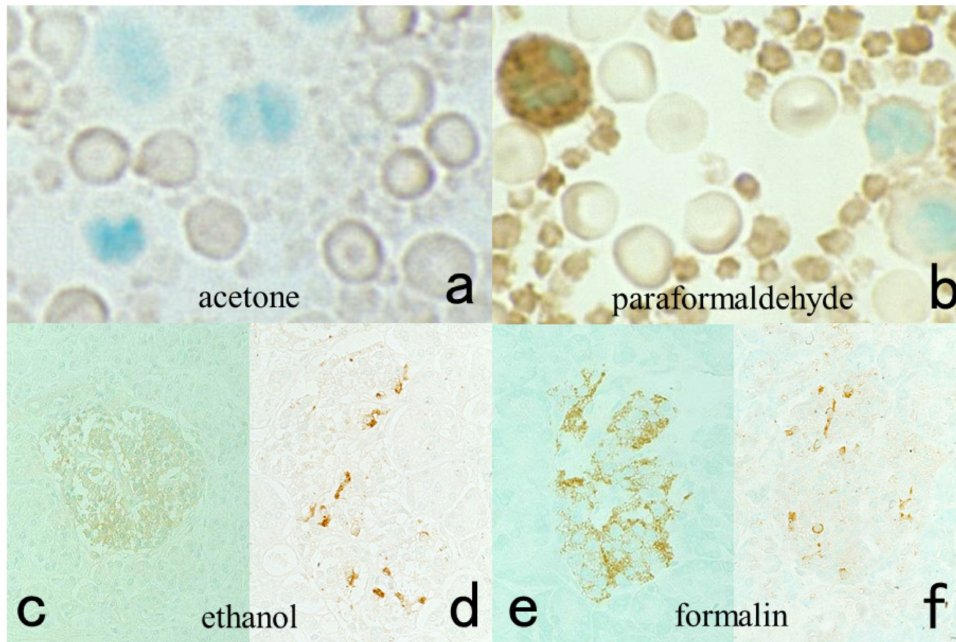
Figure 6. Antigenic loss by fixation in organic solvent. Top panels ( a , b ): Immunostaining for platelet factor 4 in a smeared buffy coat of the peripheral blood. Bottom panels ( c – f ): Immunostaining for insulin ( c , e ) and somatostatin ( d , f ) in paraffin-embedded pancreas. Left ( a , c , d ): Fixation in acetone or ethanol. Right ( b , e , f ): Fixation in 4% paraformaldehyde or in formalin. Platelet factor 4 and insulin show false negative findings when fixed in the organic solvent. Somatostatin is resistant to ethanol fixation to be clearly immunolocalized. The nuclei are counterstained with methyl